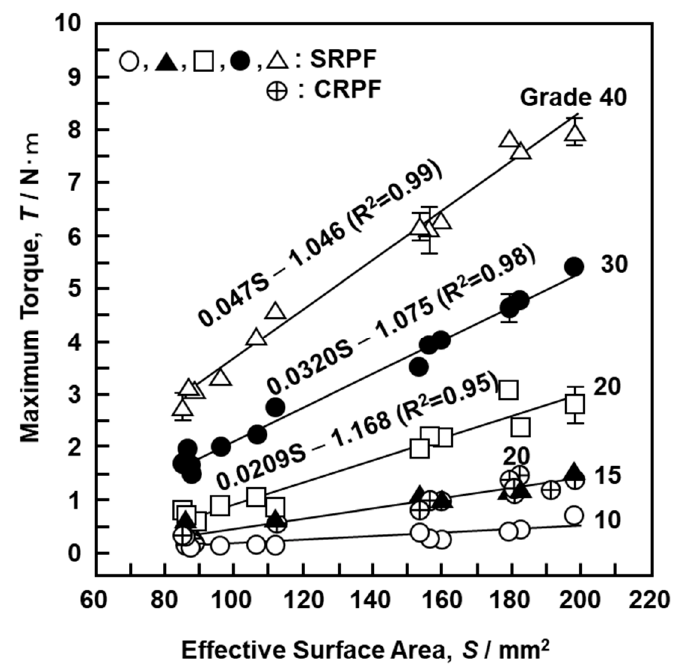
ff ect of e ff ective surface area of the screw on maximum driving Figure 11. Effect of effective surface area of the screw on maximum driving torque. Figure 11. E